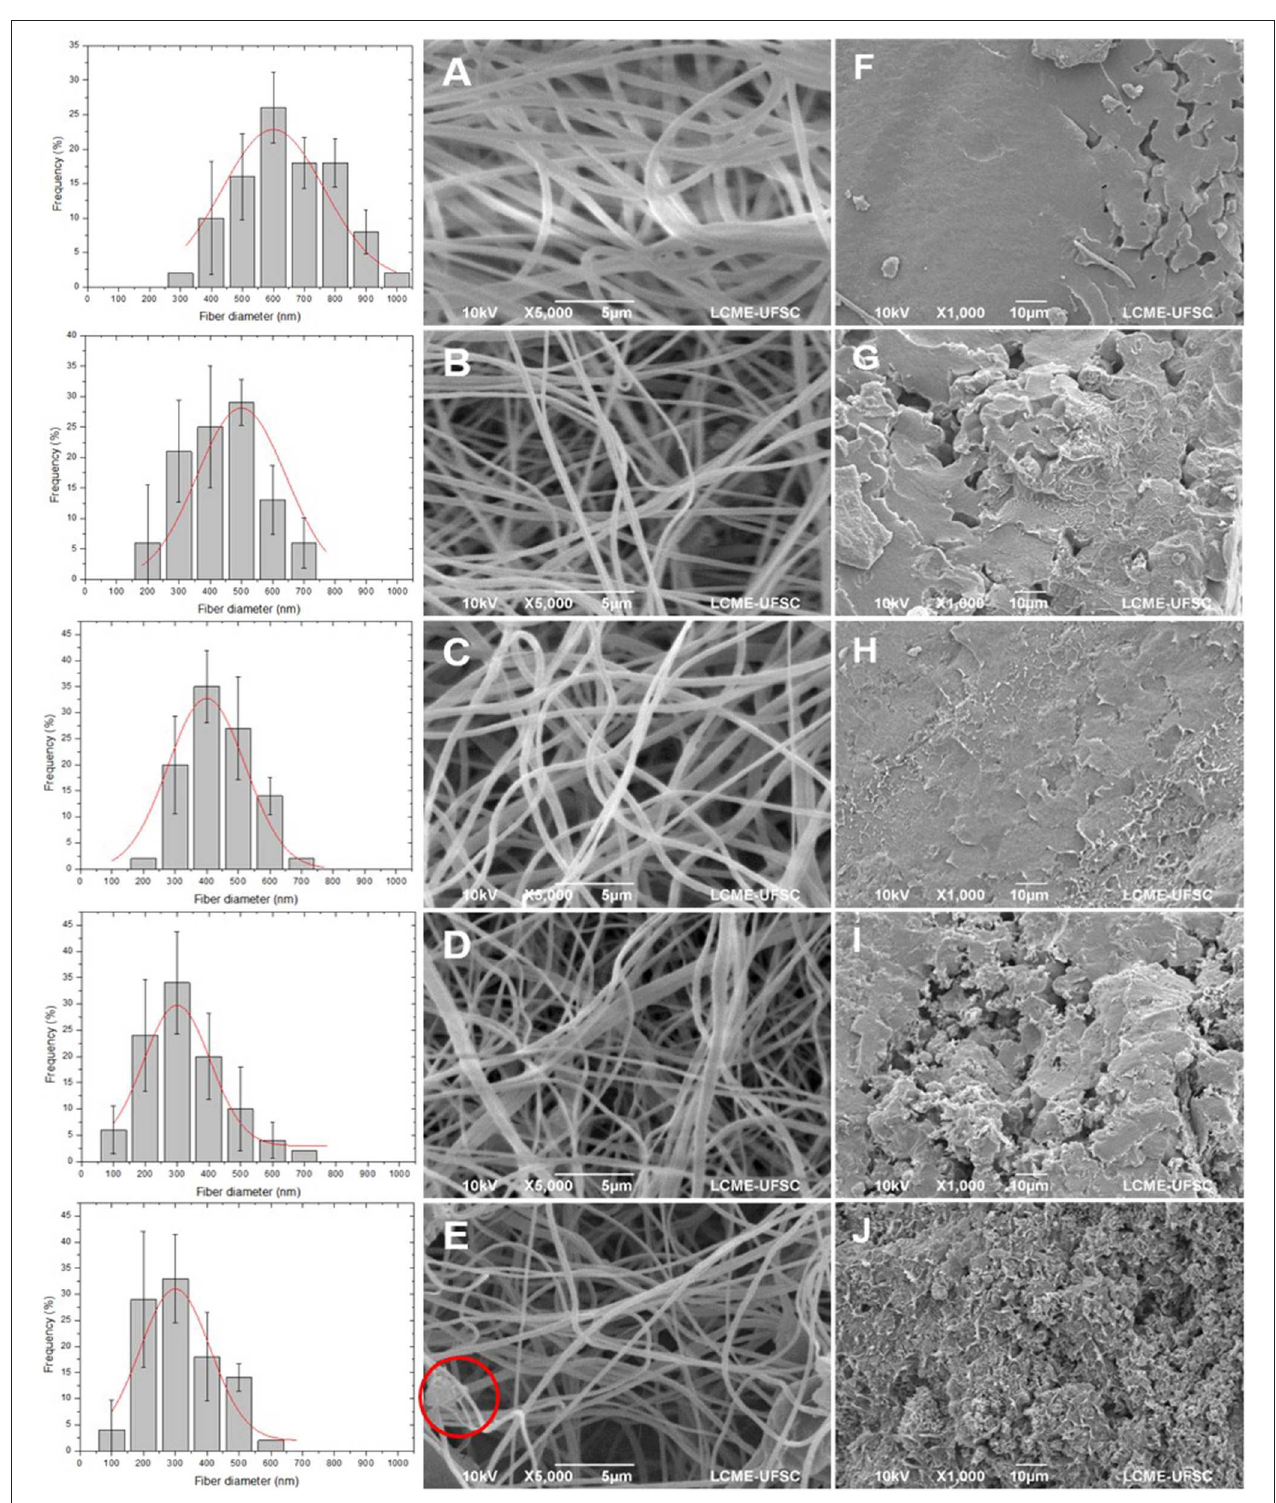
FIGURE 3 | SEM micrographs of the electrospun mats (middle) and membranes fabricated by solution casting (right): (A,F) PVDF, (B,G) PVDF/Mt-PPy.DBSA [2.5], (C,H) PVDF/Mt-PPy.DBSA [5], (D,I) PVDF/Mt-PPy.DBSA [10], (E,J) PVDF/Mt-PPy.DBSA [12.5]. The histograms are also reported.